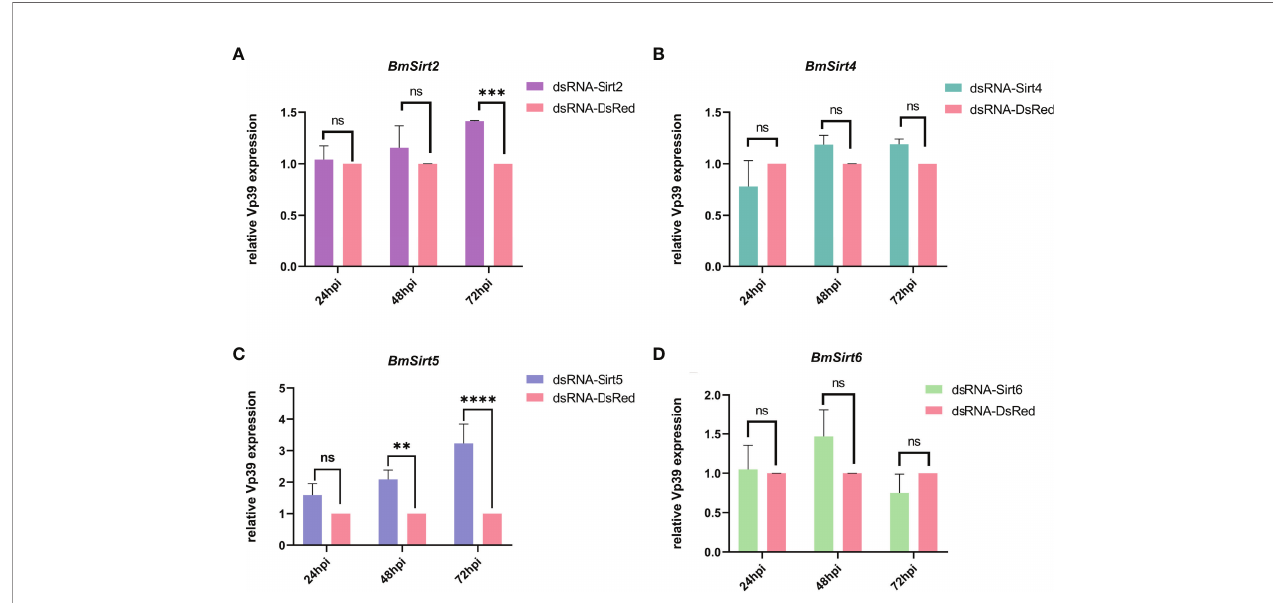
FIGURE 3 | Detection of the expression of the BmNPV capsid gene Vp39 by qRT-PCR after knockdown of Sirtuin genes in BmN cells. (A) The viral gene Vp39 was signi fi cantly up-regulated at 72 hpi after knockdown of BmSirt2 . (B) The expression of Vp39 did not change signi fi cantly after knockdown of BmSirt4 . (C) Vp39 expression was signi fi cantly up-regulated at 48 and 72 hpi after knockdown of BmSirt5 . (D) Vp39 expression did not change signi fi cantly after knockdown of BmSirt6 . The BmN cells treated with dsRNA-DsRed were used as negative control. Each bar represents the mean ± SD. **p < 0.01, ***p < 0.001, ****p < 0.0001. ns, not signi fi